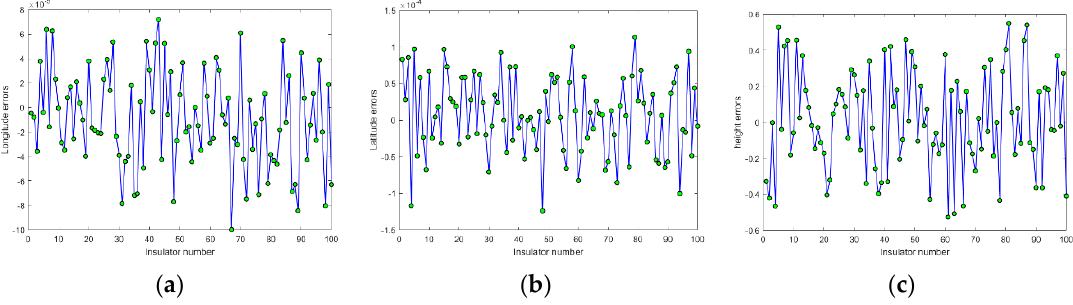
Figure 16. Errors between detected results and the manual measurement results: ( a ) longitude errors; ( b ) latitude errors; ( c ) altitude errors. Table 4. The mean and standard deviation of errors.